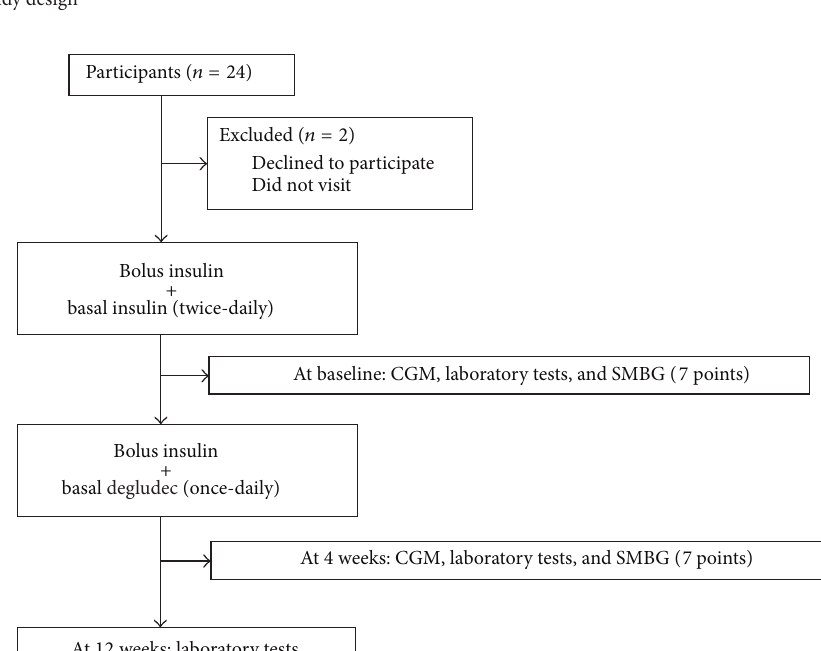
Figure 1: Study design. CGM was performed at baseline and 4 weeks after switching to insulin degludec. At 12 weeks after switching, glycemic control was evaluated by HbA1c, glycosylated albumin, and fasting plasma glucose.